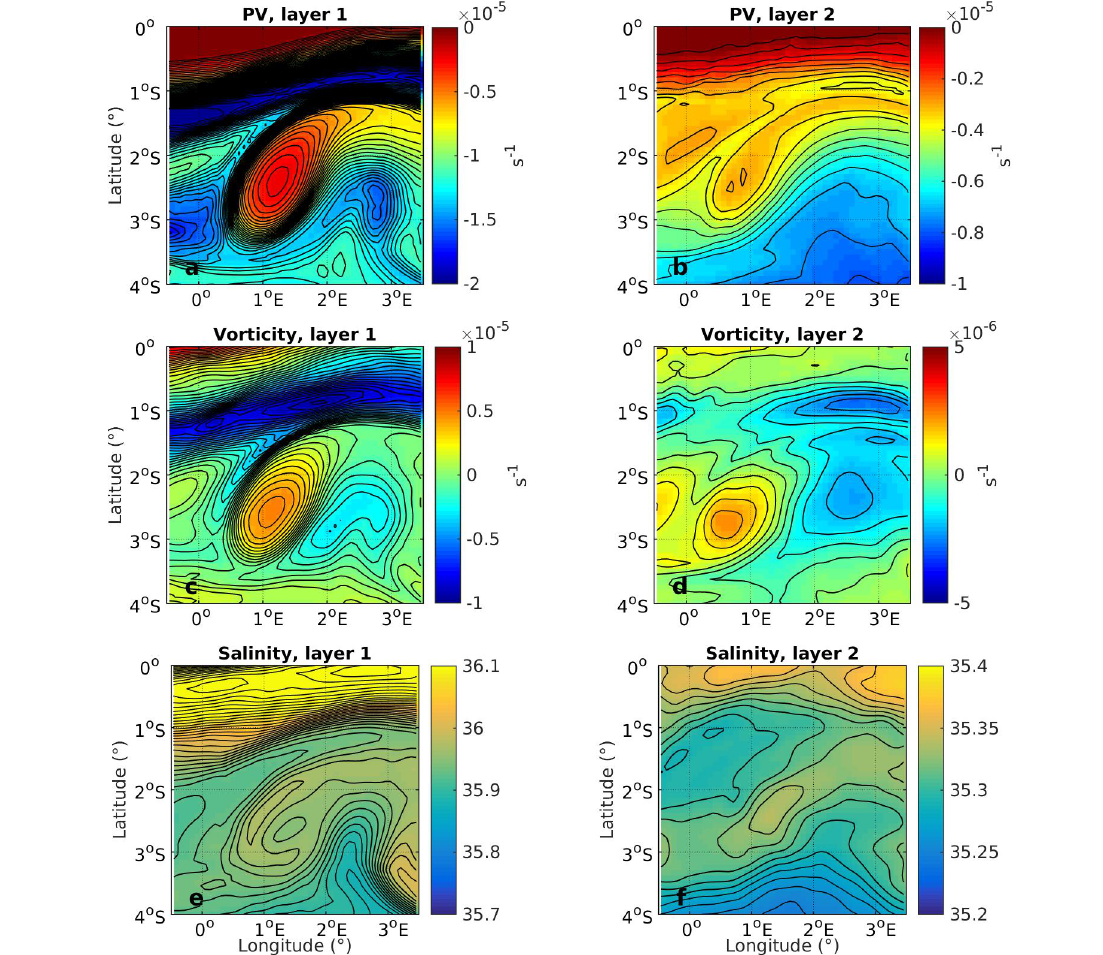
Figure 9. Horizontal maps of dynamical properties of a particular eddy, centered at [1.1 ◦ E, 2.6 ◦ S] on 10 May: isopycnic PV in layers 1 and 2 ( a , b ); isopycnic vorticity in layers 1 and 2 ( c , d ); isopycnic salinity in layers 1 and 2 ( e , f ). Steps between salinity contours is 0.01 and 5 × 10 − 7 s − 1 for PV and